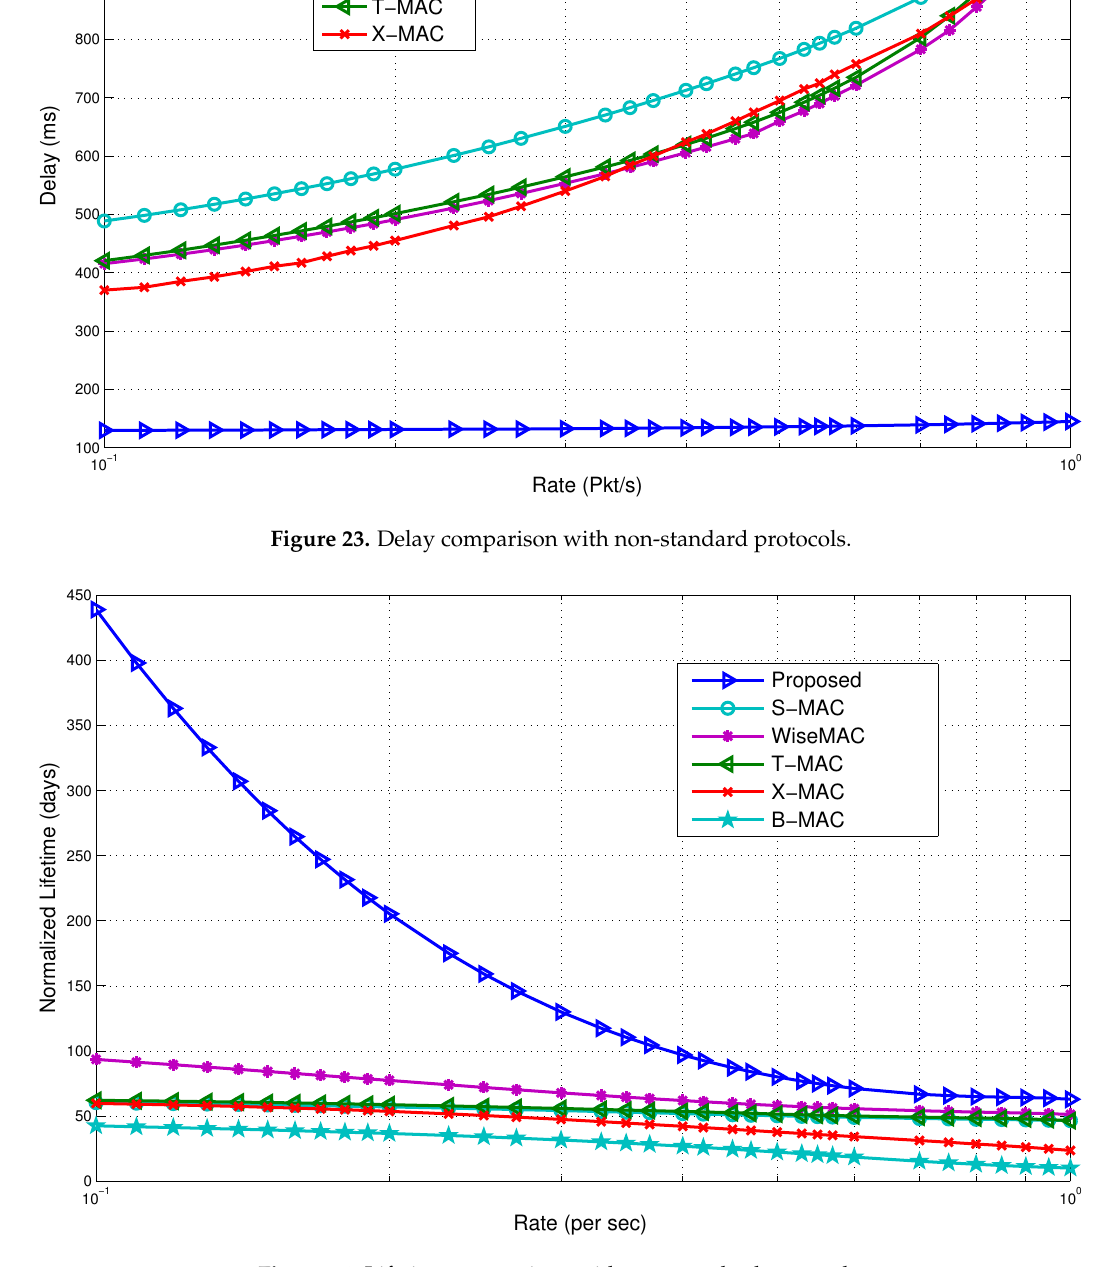
Figure 24. Lifetime comparison with non-standard